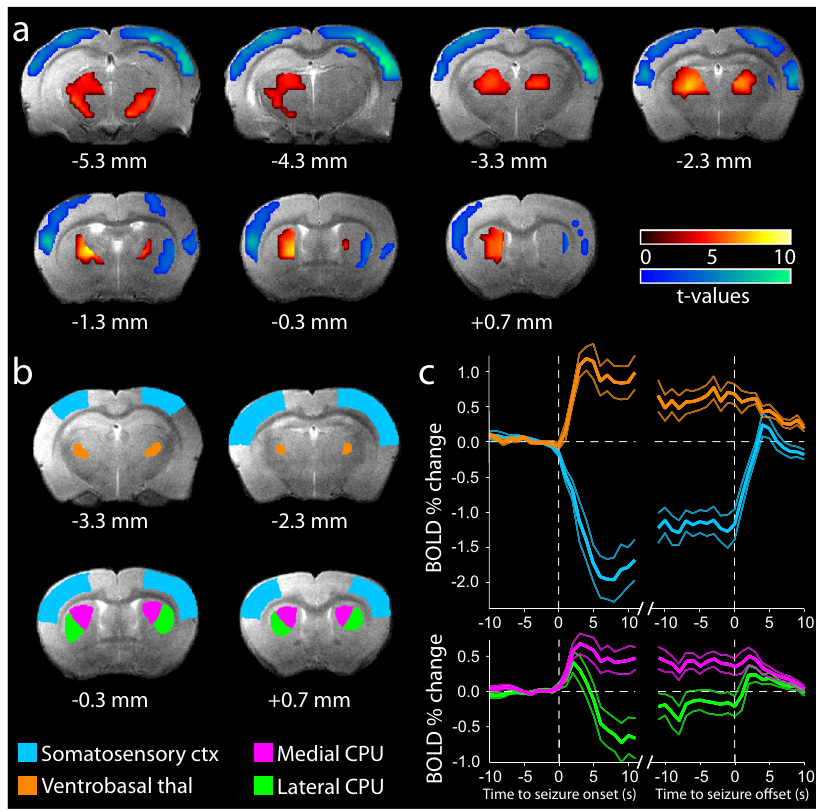
Fig. 1 | BOLD fMRI signals associated with SWDs in GAERS resemble human absence epilepsy. a Statistical Parametric Mapping (SPM) analysis of